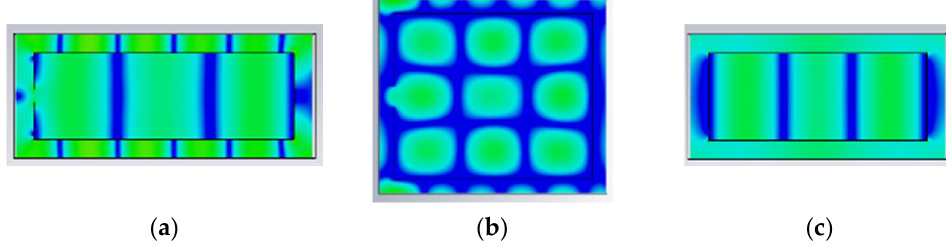
Figure 7. Field distribution of the basic model. ( a ) x section, ( b ) y section, and ( c ) z section.